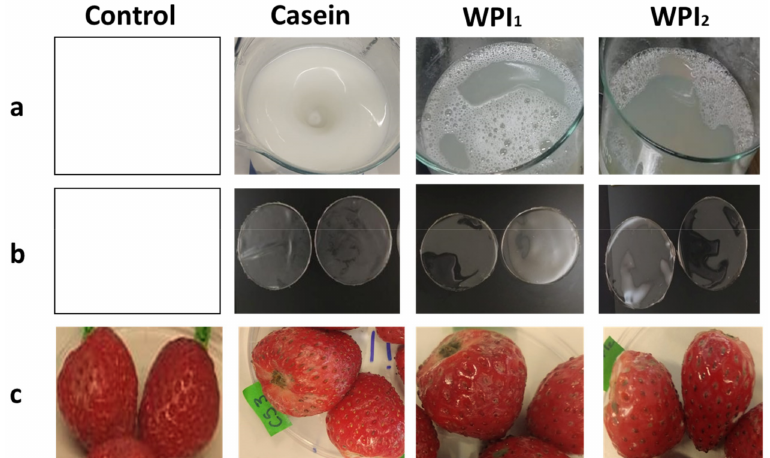
Figure 1. ( a ) Solutions used for preparing milk protein-based films. ( b ) Films based on milk proteins (casein, WPI 1 and WPI 2 ). ( c ) Example of film appearance on a fruit